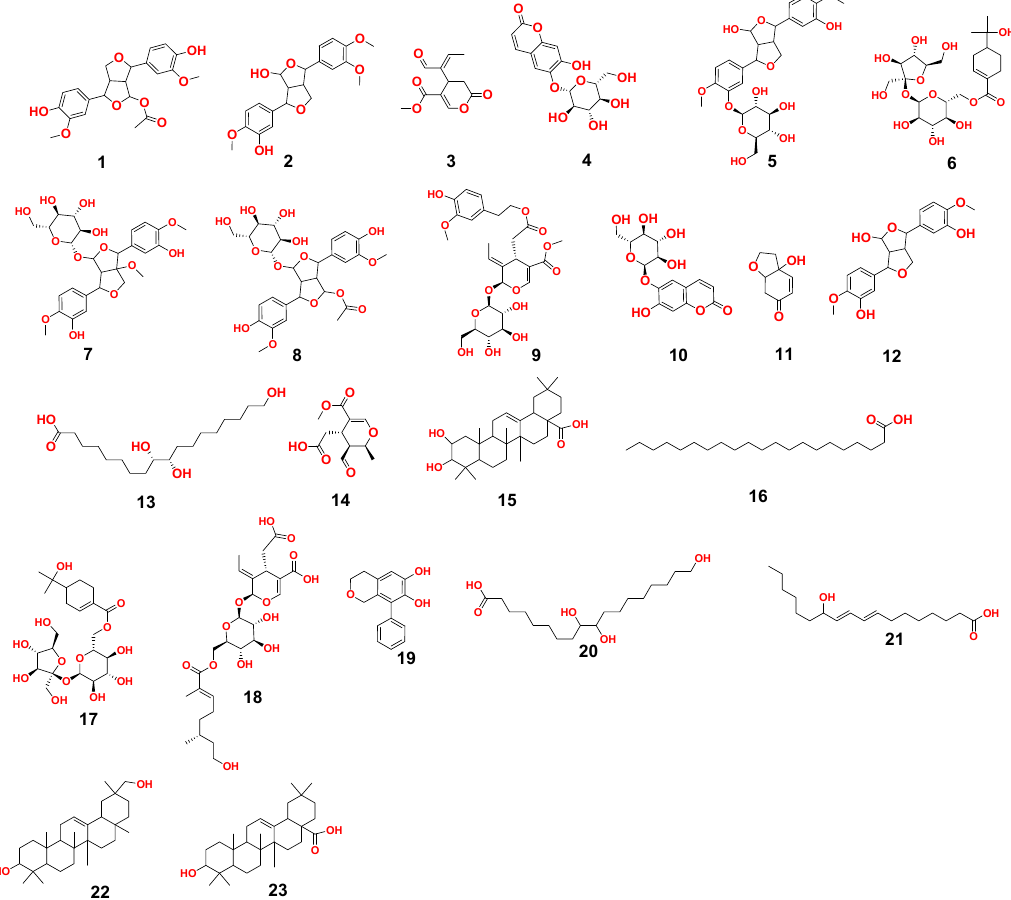
Figure 4. Dereplicated metabolites from LC-HRESIMS analysis of OEA ( 1 – 23 ). Additionally, the m / z 341.0873, 331.24803, 243.0869, and 473.36213 analogous to the